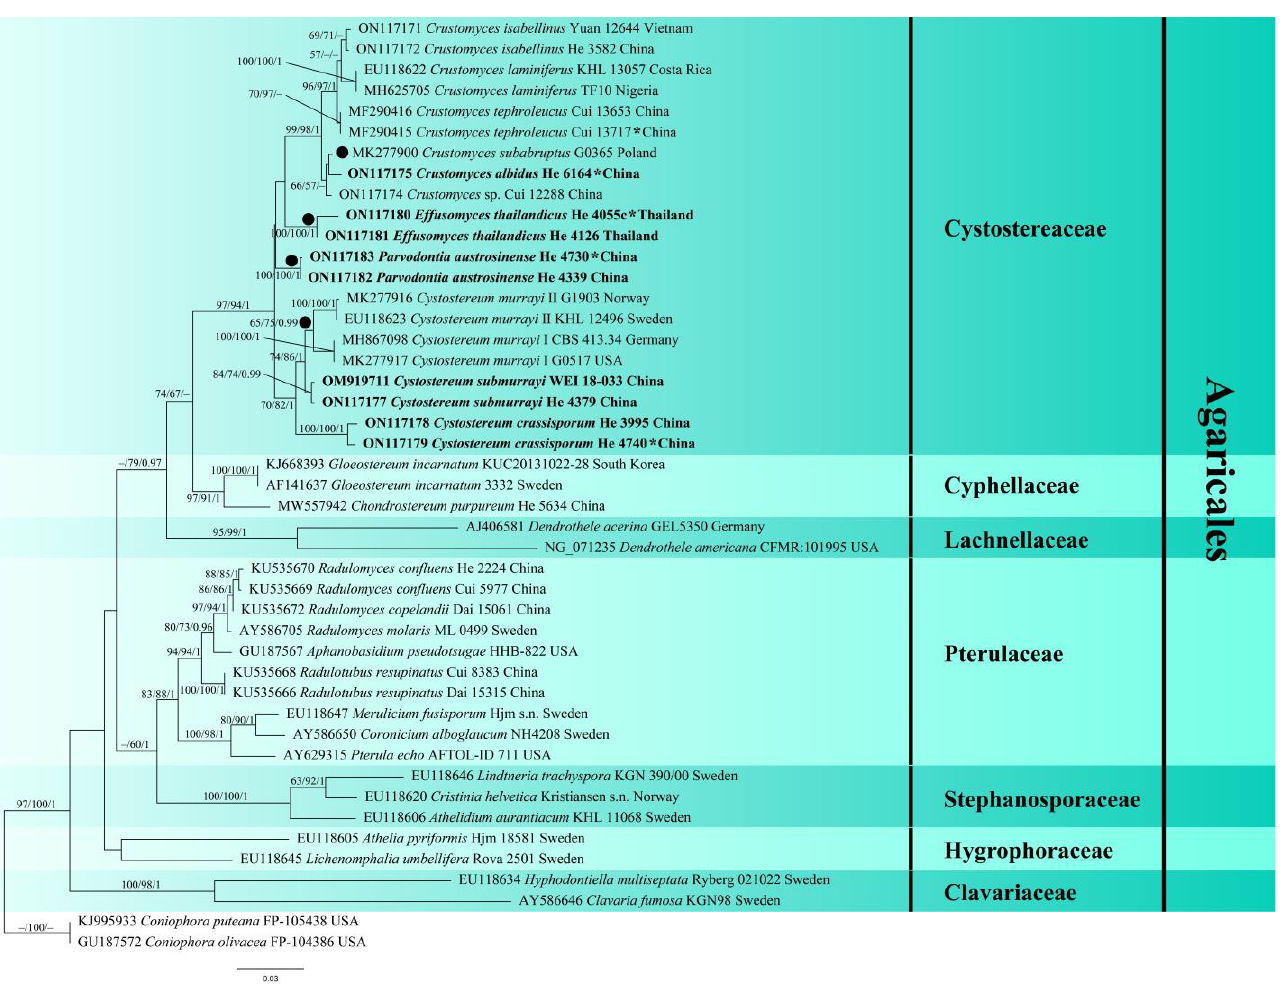
Figure 1. Phylogenetic tree of ML analysis from the LSU sequences of Agaricales taxa. Branches are labeled with parsimony bootstrap values ( ≥ 50%, first), likelihood bootstrap values ( ≥ 50%, second), and Bayesian posterior probabilities ( ≥ 0.95, third). New species are set in bold, type species of genera in Cystostereaceae are marked with a solid circle ( ● ) in front of the branch, and holotypes of new taxa are marked with an asterisk (*).